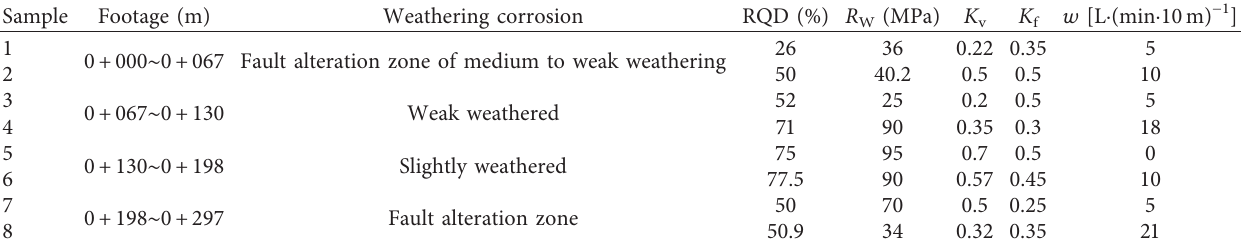
Table 1: Rock mass data of the underground engineering in Guangzhou pumped storage power plant [41].